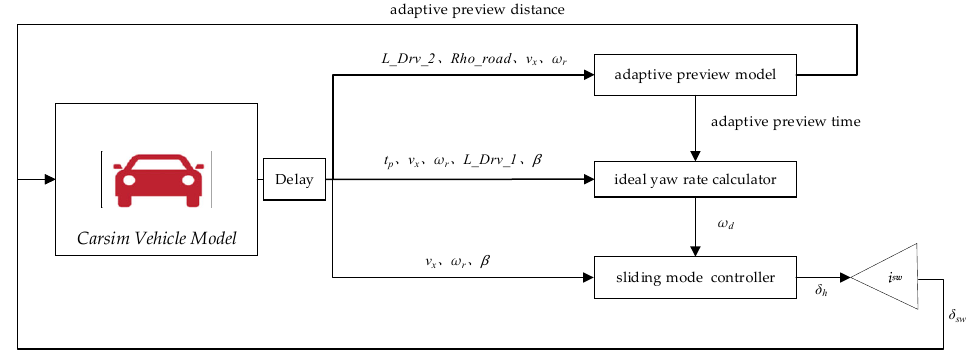
Figure 9. Carsim – Simulink Joint Simulation Model.